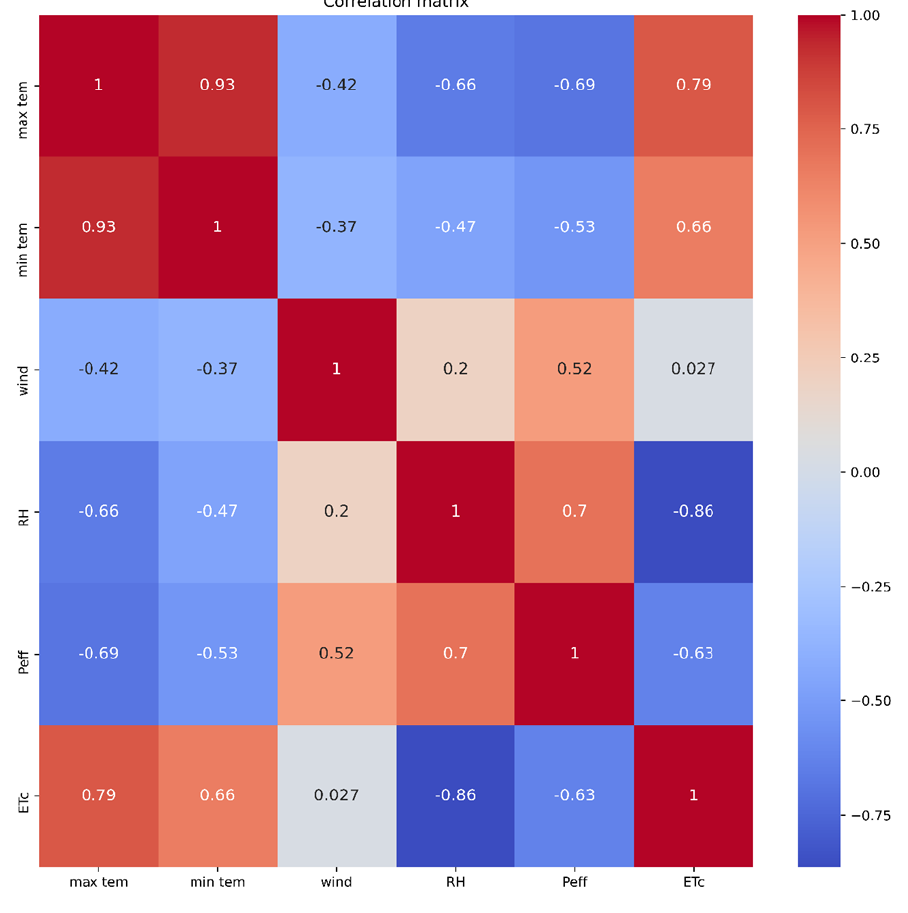
Figure 4. Correlation matrix between max. temperature, min. temperature, wind speed and relative humidity.